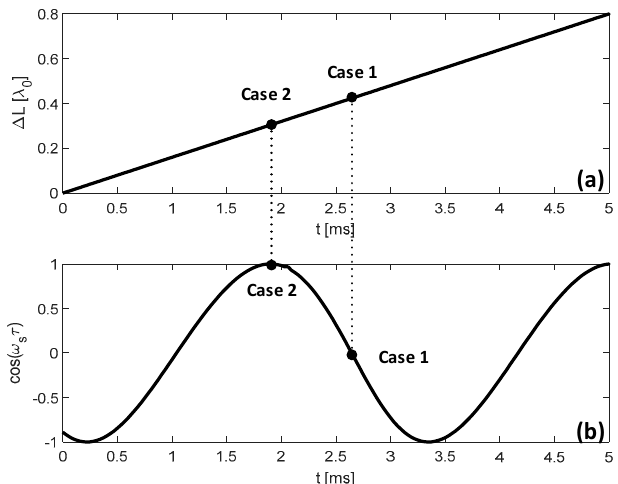
Figure 2. Simulation results with L = 15.0 cm, κ = 0.00003, J = 1.5 J th and α = 3. ( a ): ∆ L vs. Time; ( b ): An SMI signal.